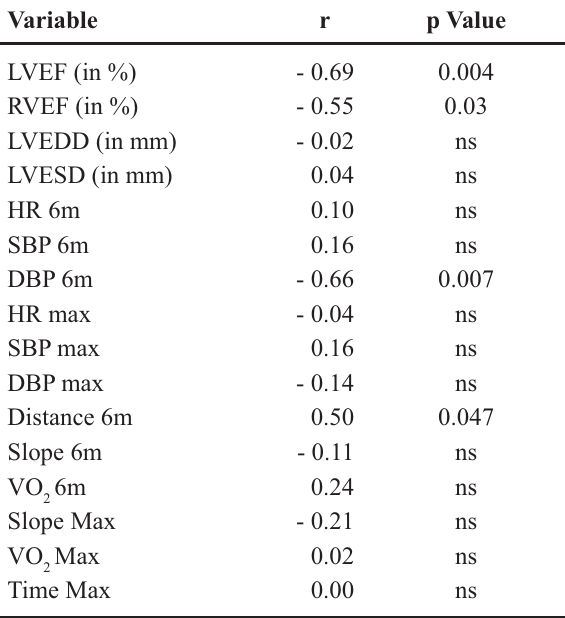
Table 4 – Linear regression results between total testos- terone serum levels and cardiac function, and exercise